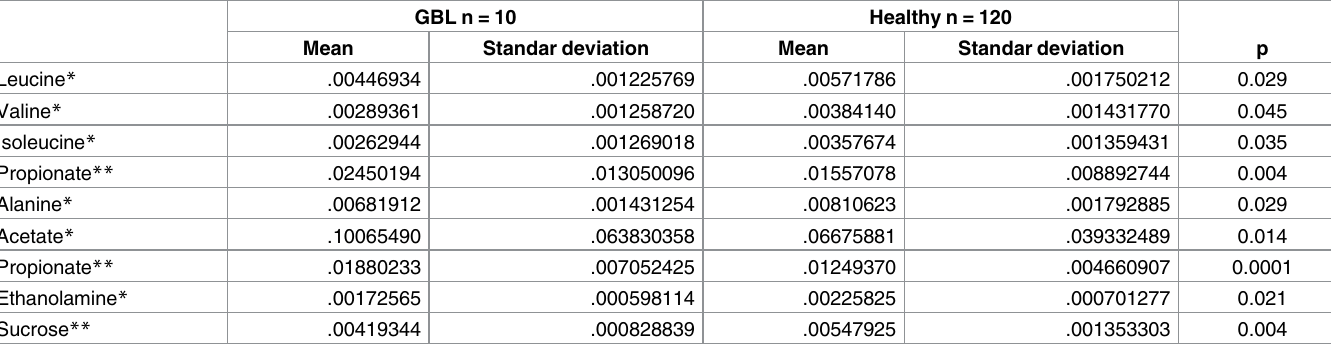
Table 2. Metabolites identified and compared between GBM and control groups. * p < 0.05 and ** p <